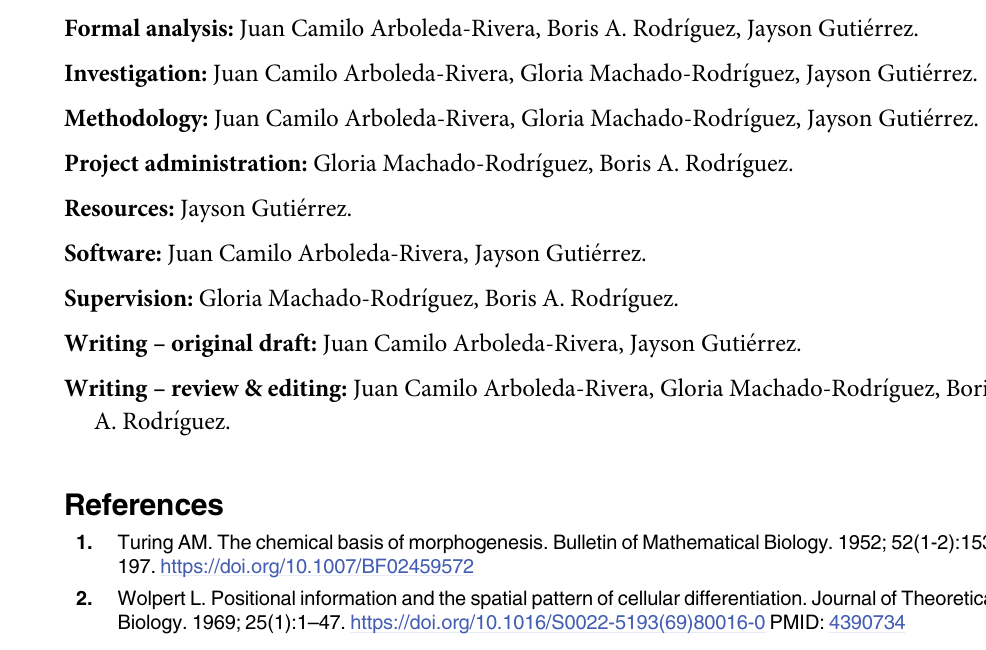
S1 Table. Proportion of relevant subgraphs in the set of GRNs. The 19 subgraphs presented in this table are those presented in S2 Fig. Most of the topologies presented at least one nega- tive feedback loop (70.73%), and 62.46% of them presented the I3-FFL network motif. The robustness of each subgraph was calculated as the mean robustness of the topologies present- ing that subgraph. S2 Table. Average fitness of each topology in different morphogenetic fields. The average fitness by topology is reported for morphogenetic fields with 10, 20, 40 and 50 cells. Data from this table are shown in S3(B)